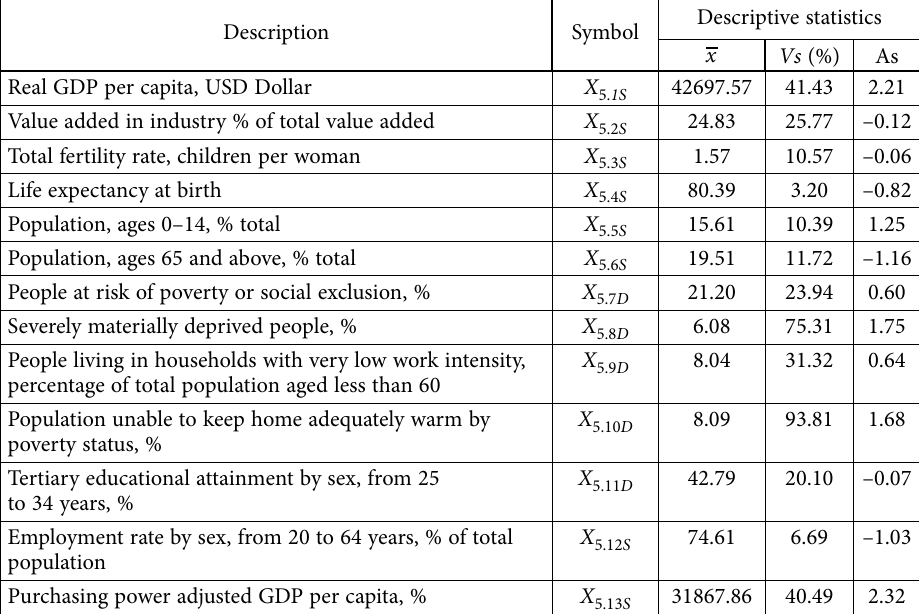
Table 6. Socio-economic